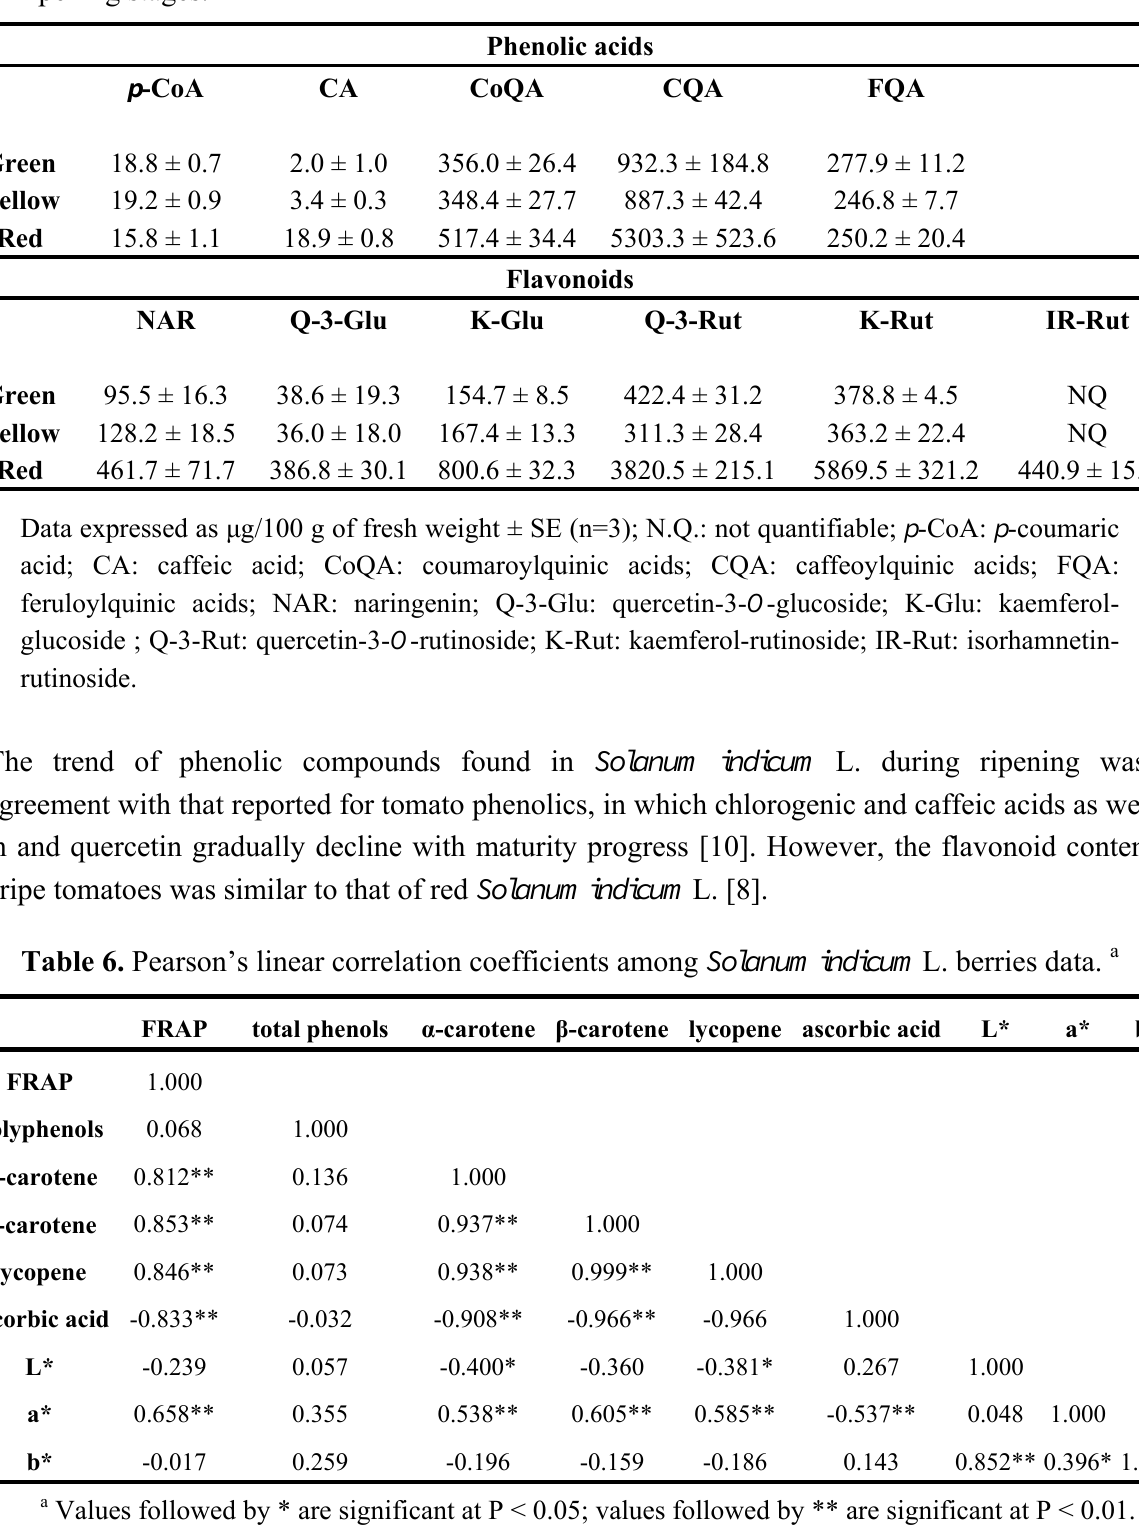
Table 5. Quantification of phenolic compounds in Solanum indicum L. berries at different ripening stages.